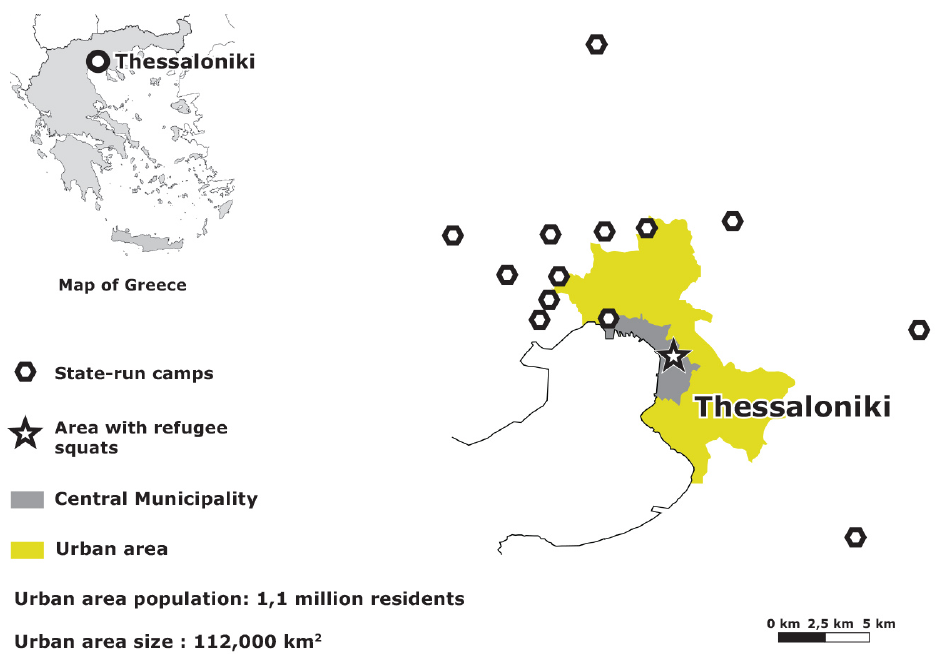
Figure 2. Locations of state-run refugee camps and refugee squats in Thessaloniki. Source: Authors, based on the land use map of Regulatory Urban Plan of Athens and Thessaloniki Metropolitan Areas